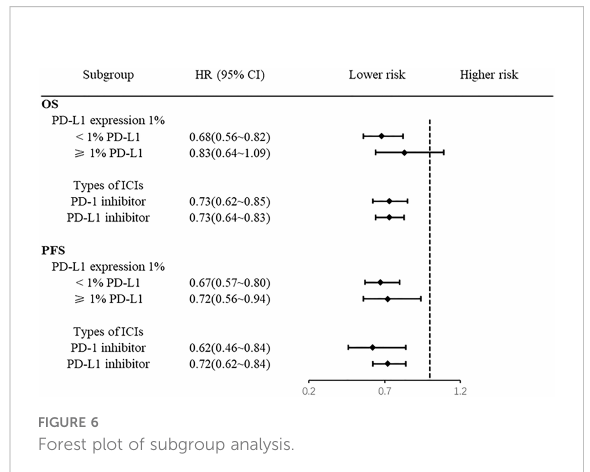
FIGURE 6 Forest plot of subgroup